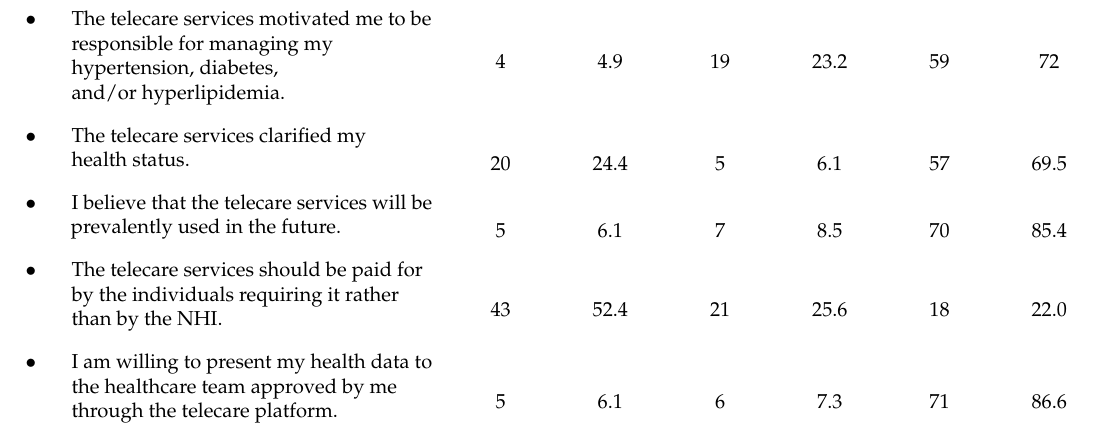
Disagree Number and Percentage (%)